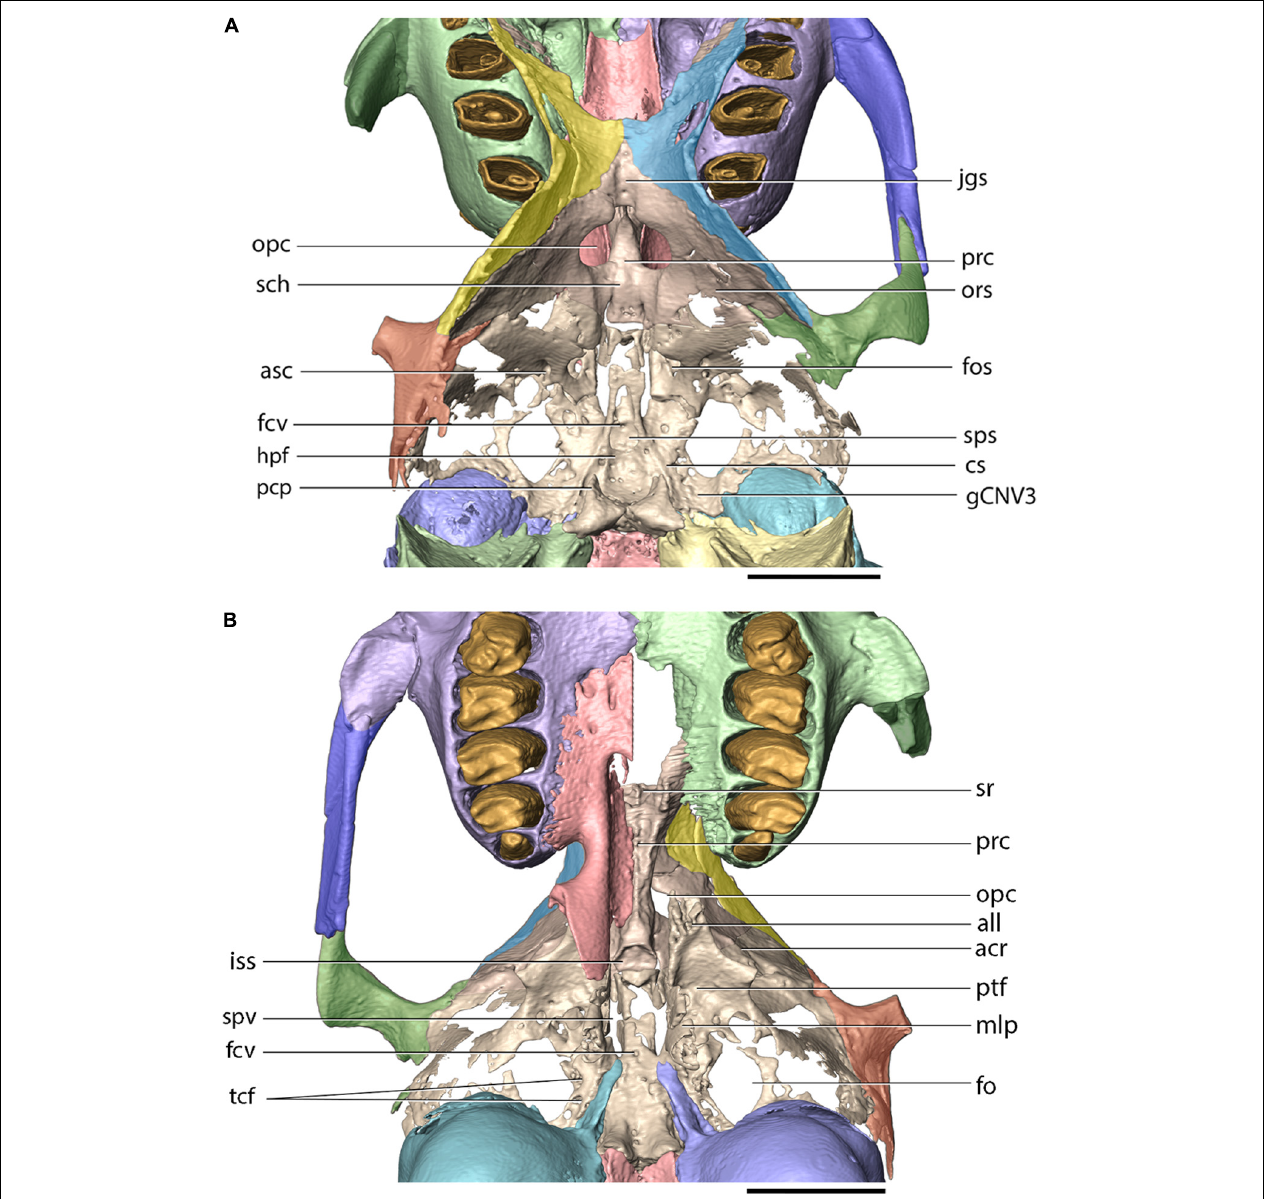
FIGURE 8 | Cranial base of Palaeolagus haydeni (FMNH PM9476) in (A) dorsal and (B) ventral views. Frontal (orbital portion)-presphenoid-basisphenoid-squamosal figured as complex (internal sutures not visible in CT data). acr, alisphenoid crest; all, apex of lateral lamina of pterygoid process; asc, alisphenoid canal; cs, carotid sulcus; fcv, foramen cavernosum; fo, foramen ovale; fos, superior orbital fissure; gCNV3, groove for root of CN V3 and semilunar ganglion; hpf, hypophyseal fossa; iss, presphenoid surface of intersphenoidal synchondrosis; jgs, jugum sphenoidale; mlp, medial lamina of pterygoid process of palatine; opc, optic canal; ors, orbitosphenoid; pcp, posterior clinoid process; prc, presphenoid corpus; ptf, pterygoid fossa; sch, sulcus chiasmatis; sps, sphenoidal sinus; spv, sphenopalatine vacuity; sr, sphenoidal recess; tcf, transverse canal foramina. Scale bar = 5